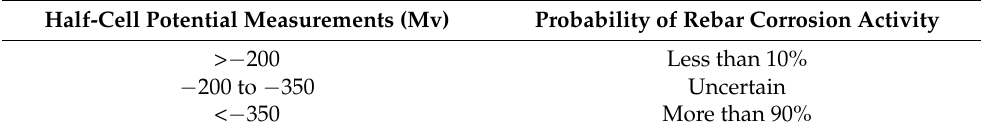
Table 2. ASTM C876 for interpretation of half-cell measurements [33]. Half-Cell Potential Measurements (Mv) Probability of Rebar Corrosion Activity > − 200 Less than 10% − 200 to − 350 Uncertain < − 350 More than